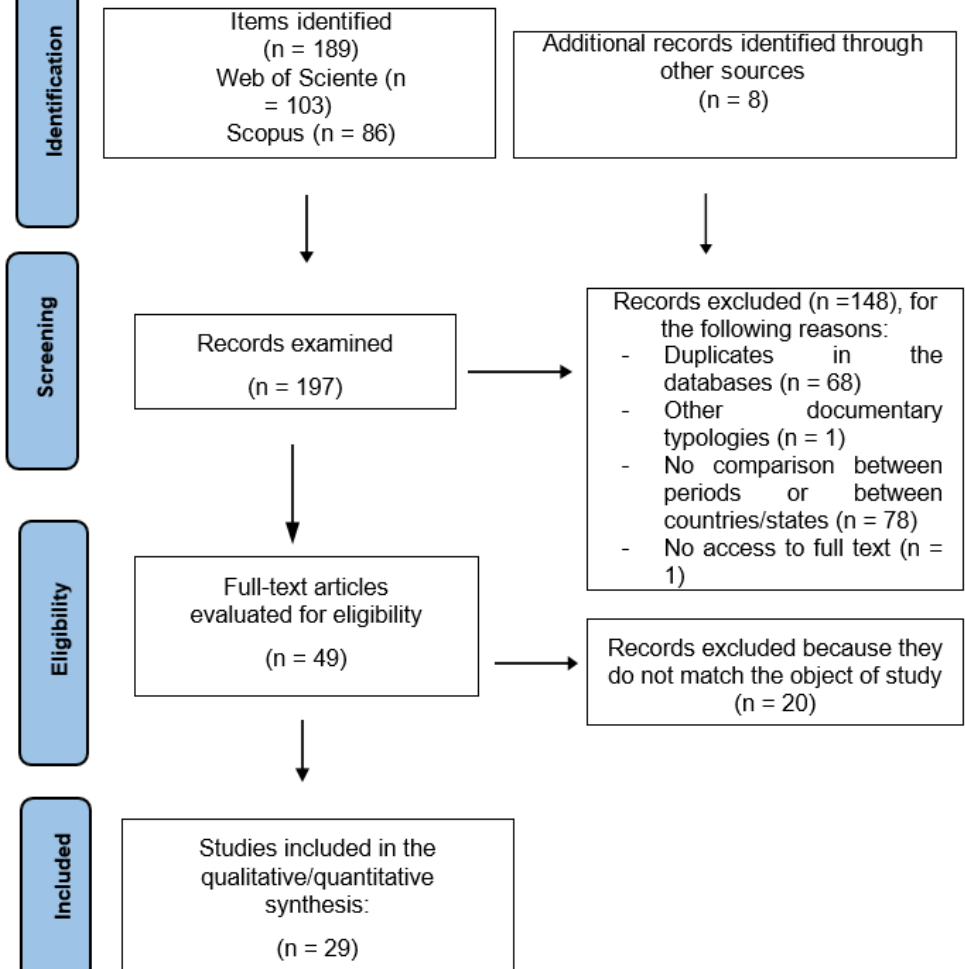
Figure 1. Flow of information through the different phases of a systematic review.